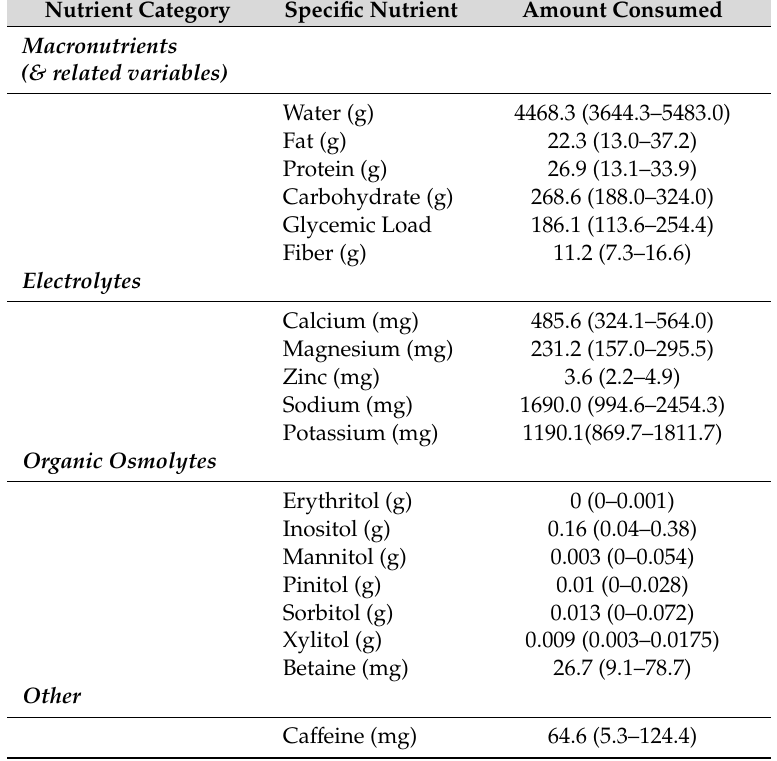
Table 2. Summary statistics for nutrient intake the morning of and during the ride (mean